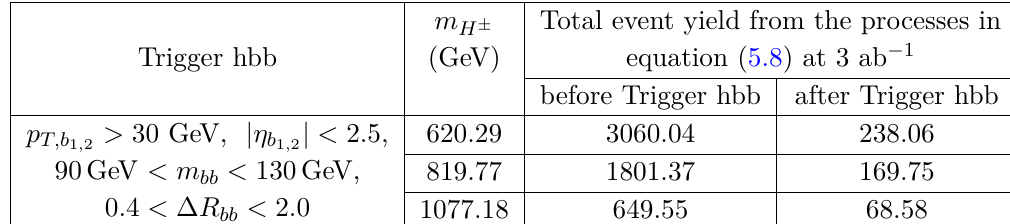
Table 32. Summarising the trigger cuts (additional cut: p the event yield at 3 ab − 1 in the b ¯ b + LLCP category.